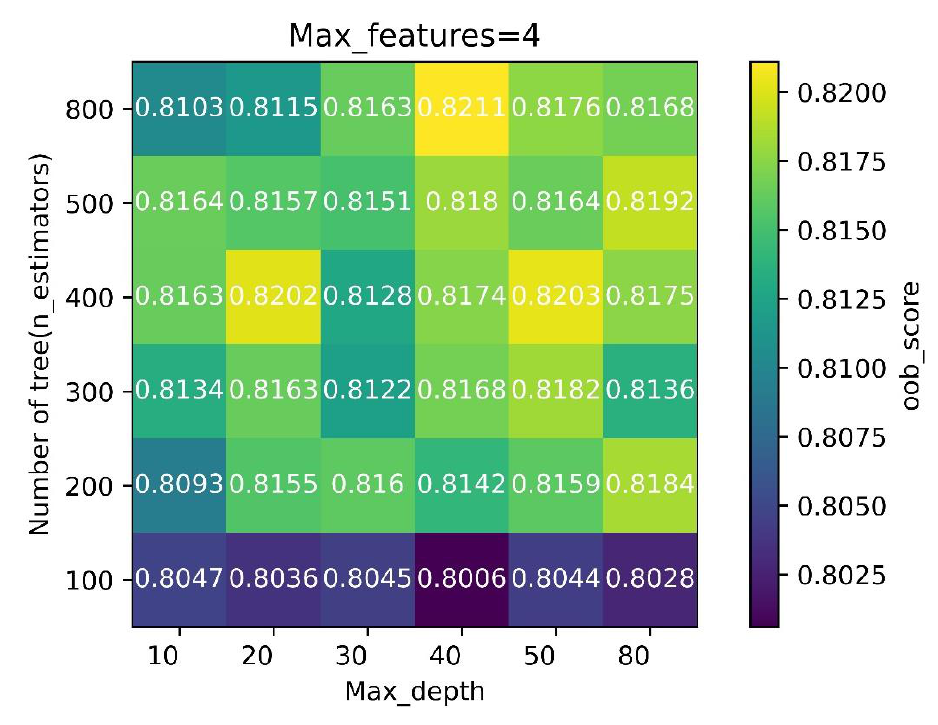
Table 3. The importance scores of predictive variables in the RF model and their corresponding rankings based on the configuration n_estimators= 400, max_depth = 20, min_samples_split = 2, min_samples_leaf = 7, and max_features = 4 for CP classification.